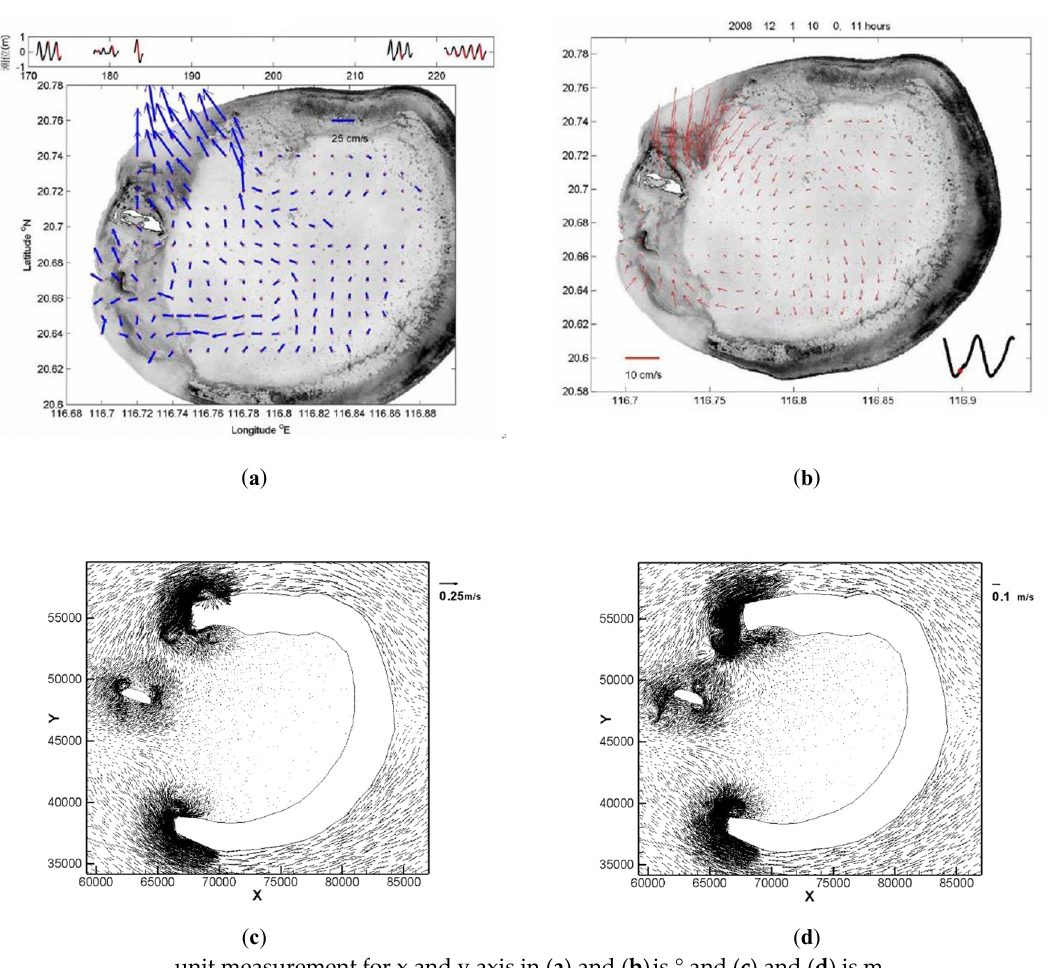
unit measurement for x and y axis in ( a ) and ( b ) is ° and ( c ) and ( d ) is m Figure 11. The measured flow field at ( a ) ebb tides and ( b ) flood tides, and the computed flow field at ( c ) ebb tides and ( d ) flood tides. ( c ) ebb tides and ( d ) flood